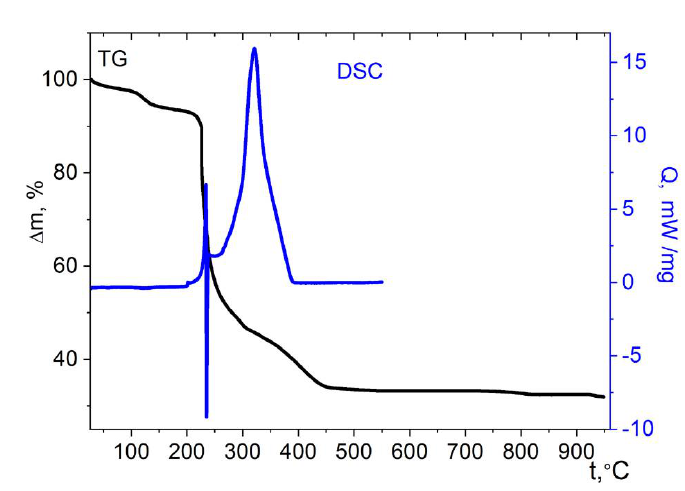
Figure 16. Thermolysis of complexes 8 under